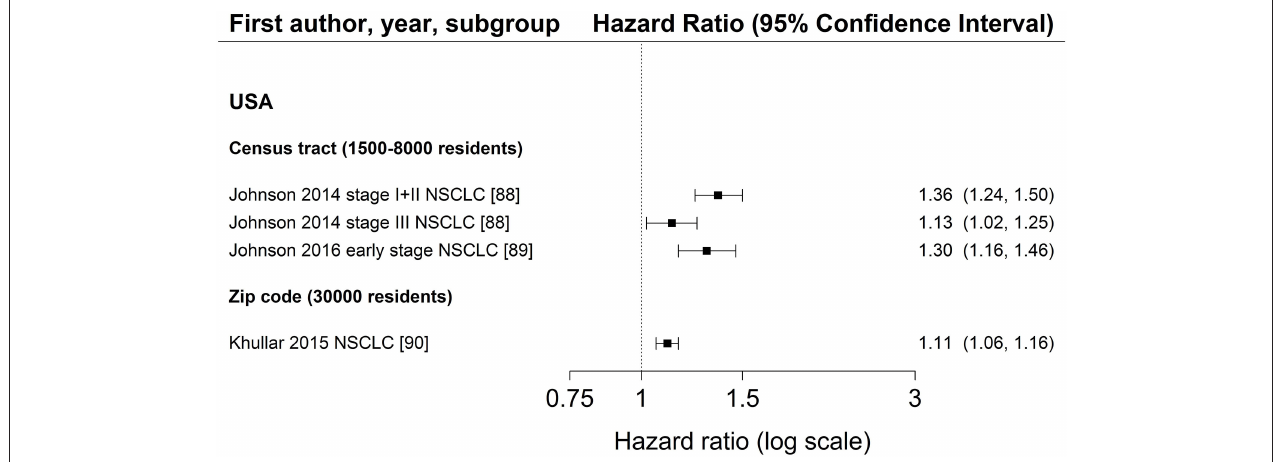
FIGURE 3 | Association of area-based education (reference: high education) and survival after lung cancer. Order: small to large area level. NSCLC, non-small cell lung cancer.